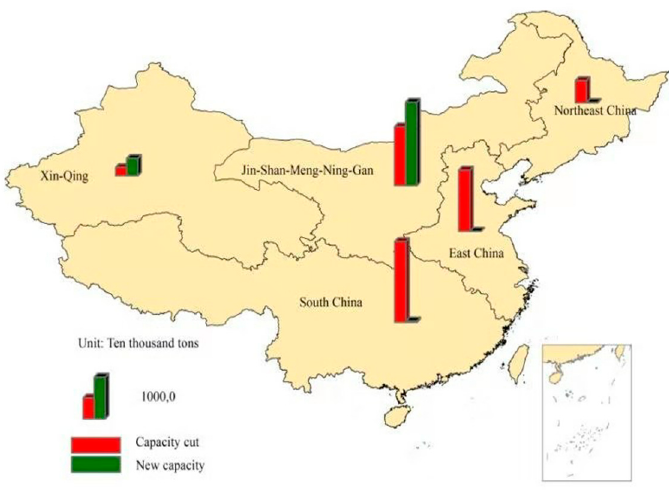
Figure 6. China’ five main coal production areas.